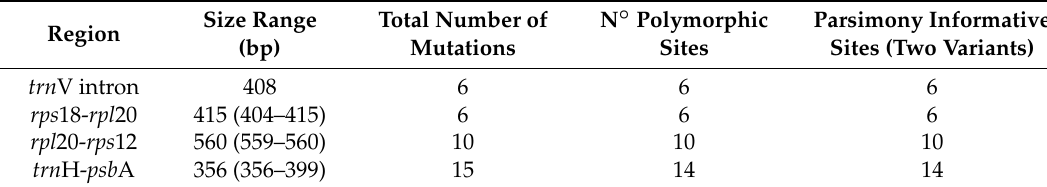
Table 2. Characteristics of the four chloroplast DNA spacer regions of Dipteronia Oliv.